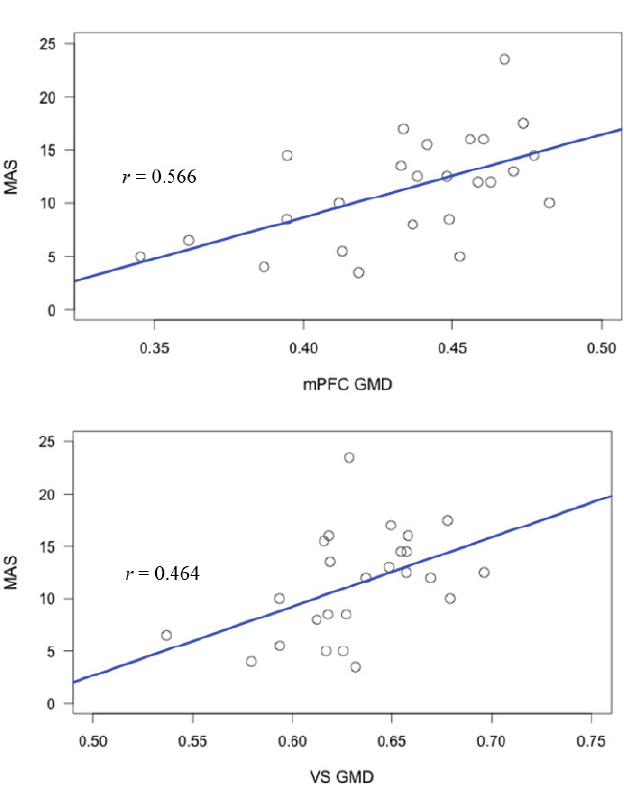
Figure 2. Scatterplots of GMD in significant clusters and group total metacognition